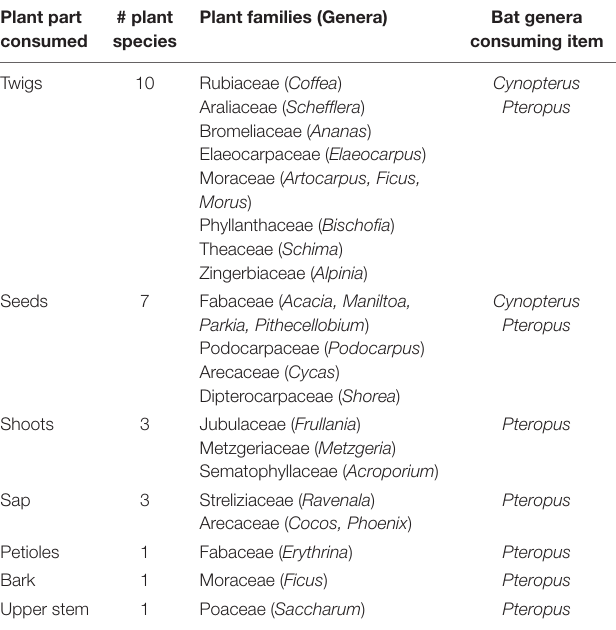
TABLE 1 | Plant parts that are a minor component in the diet of pteropodid